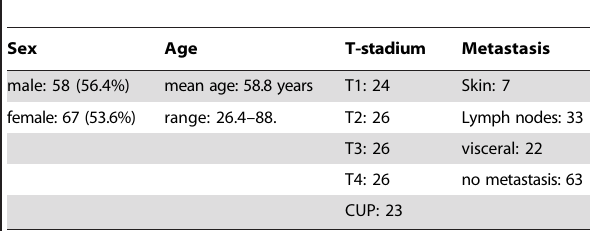
Table 1. Patient